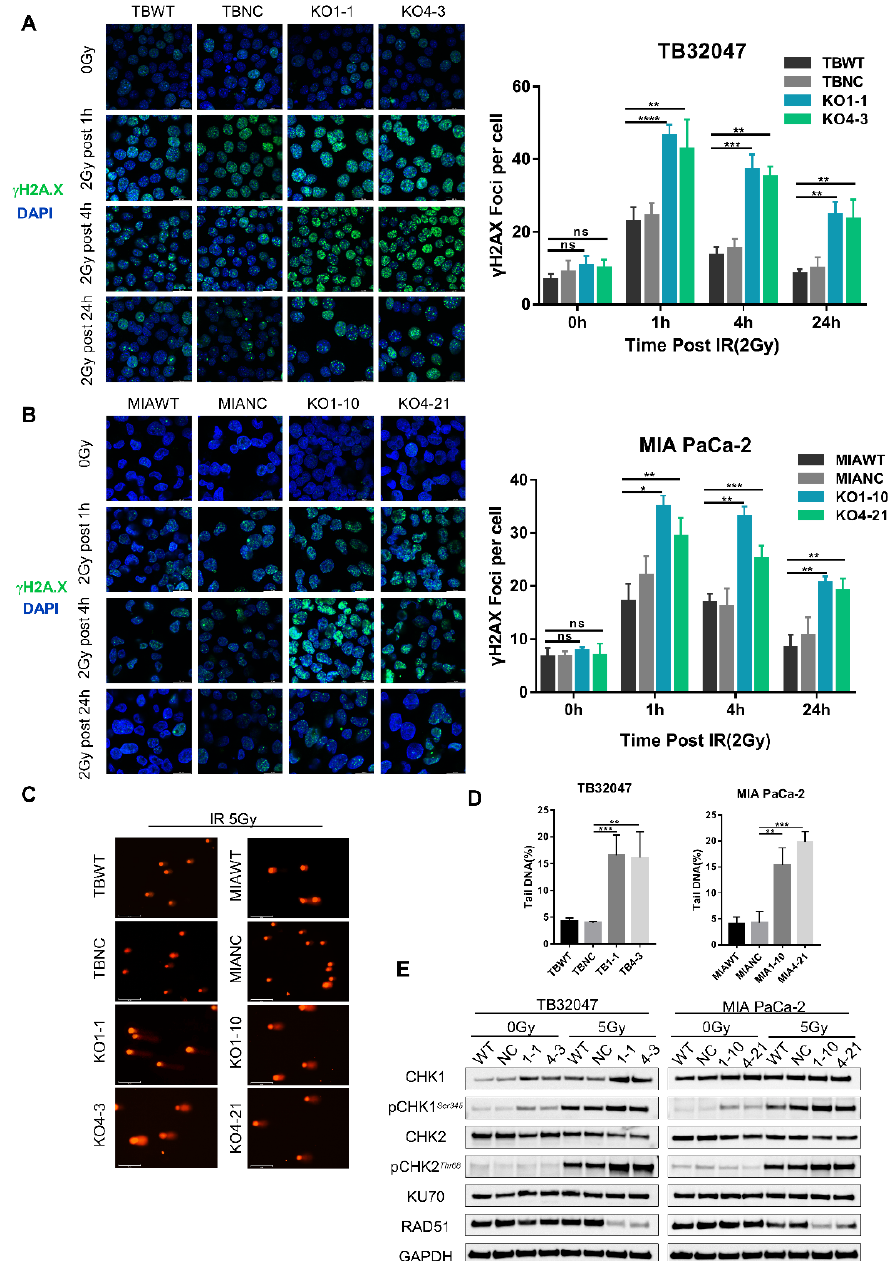
Figure 3. DYRK1A knockout increases DNA damage and DNA double-strand breaks in pancre- atic cancer cells after radiotherapy. ( A , B ) Immunofluorescence of TB32047 ( A ) and MIA PaCa-2 ( B ) control or DYRK1A KO single clones at different time points with 2Gy irradiation. Representative images of three independent experiments ( n = 3) and statistical analysis are shown. (Blue-DAPI, Green- γ H2A.X. Scale bar: white, 20 µ m). *, p < 0.05; **, p < 0.01; ***, p < 0.001 and ****, p < 0.0001 by 2-tailed unpaired Student’s t test. ns. not significant. ( C ) Alkaline comet assay of TB32047 and MIA PaCa-2 knockout single cells and control cells after irradiation with 5 Gy X-rays. Representative images of three independent experiments ( n = 3) are shown (scale bar: white, 125 µ m). ( D ) CASP software analysis of the percentage of DNA content in the comet tail of the alkaline comet experiment. A minimum of 50 cells were statistically analyzed. **, p < 0.01 and ***, p < 0.001 by 2-tailed unpaired Student’s t test. ( E ) Western blot of TB32047 and MIA PaCa-2 control or DYRK1A KO single clone cells with 0 Gy or 5 Gy irradiation after 24